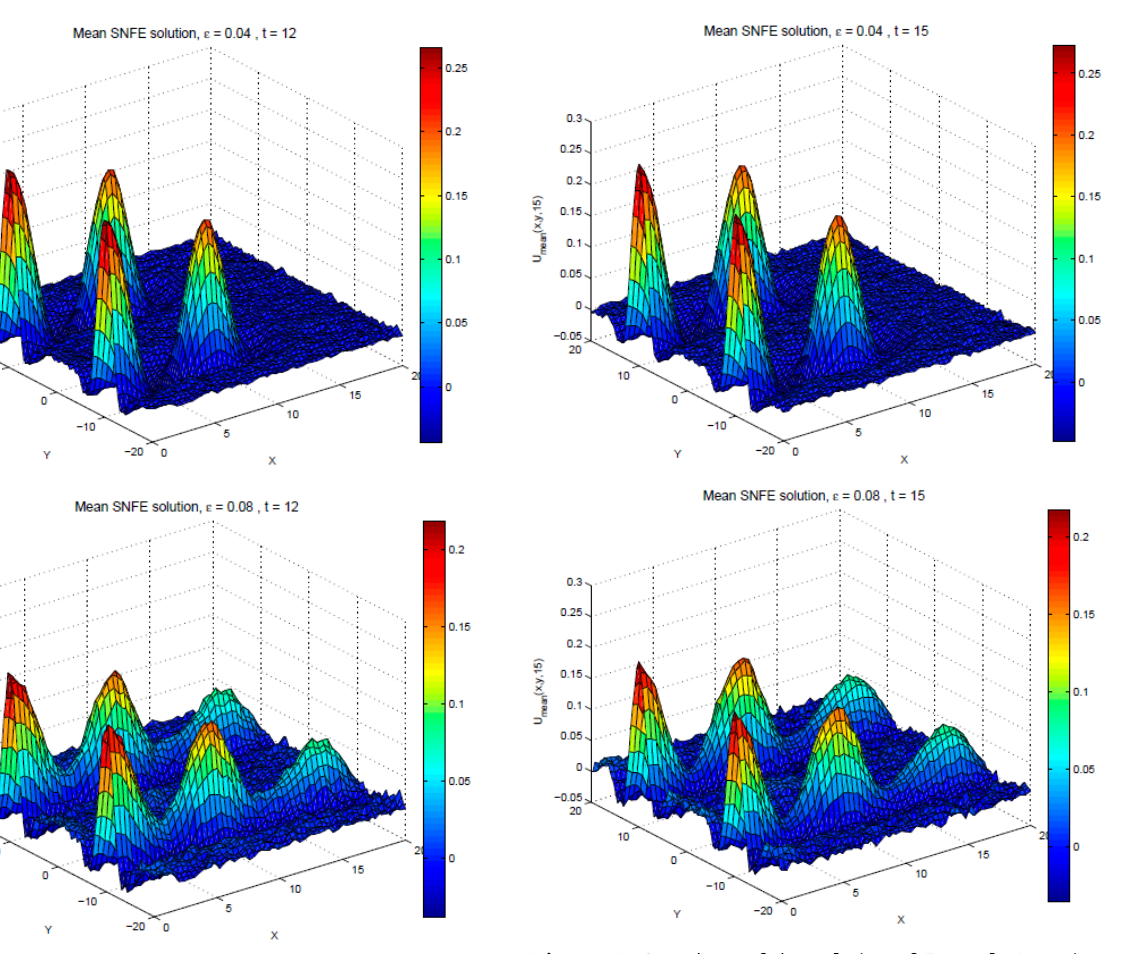
Figure 15. Snapshots of the solution of Example 3 at time t = 15: up- E = 0; down, left-hand side -E = 0.04; down, right- hand side - E =